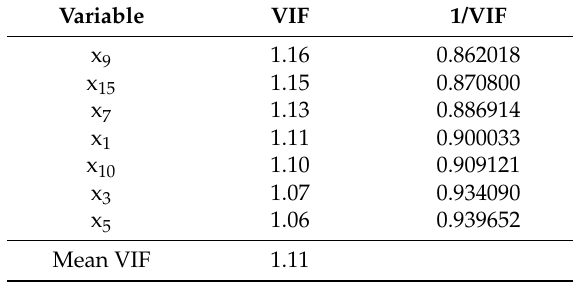
Table 2. Multicollinearity test.